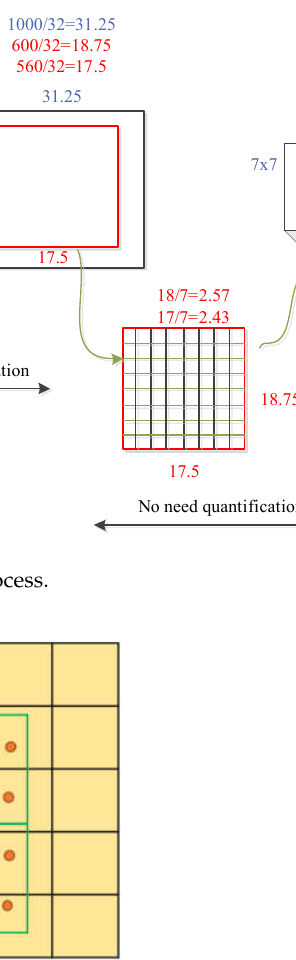
Figure 7. ROI align interpolation.